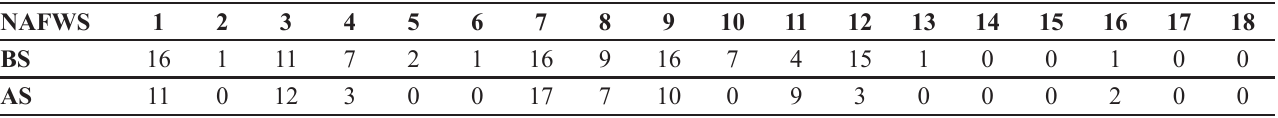
TABLE I - Individual evaluations of the number of areas on the foot without sensation (NAFWS) in type 2 diabetic patients before supplementation (BS) and after supplementation (AS) with glutamine dipeptide. The numbers 1-18 represent each patient included in the